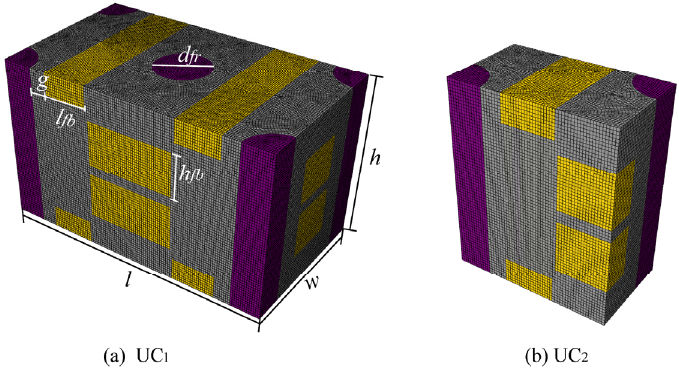
Figure 10. Temperature and heat flux distributions of the carbon fiber rod: ( a ) temperature, ( b ) heat flux.